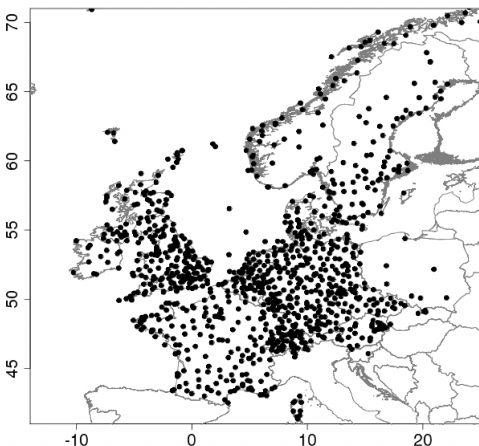
Figure 5. The location of weather stations with 15 or more years of peak gust measurements in the EU-RMS-42 data